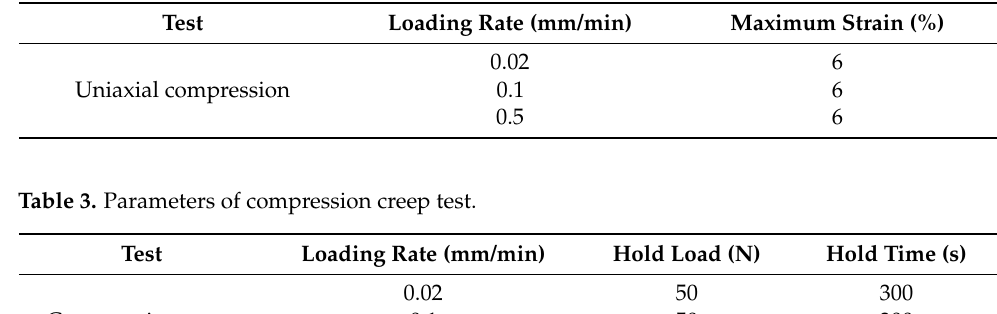
Table 2. Parameters of uniaxial compression test.